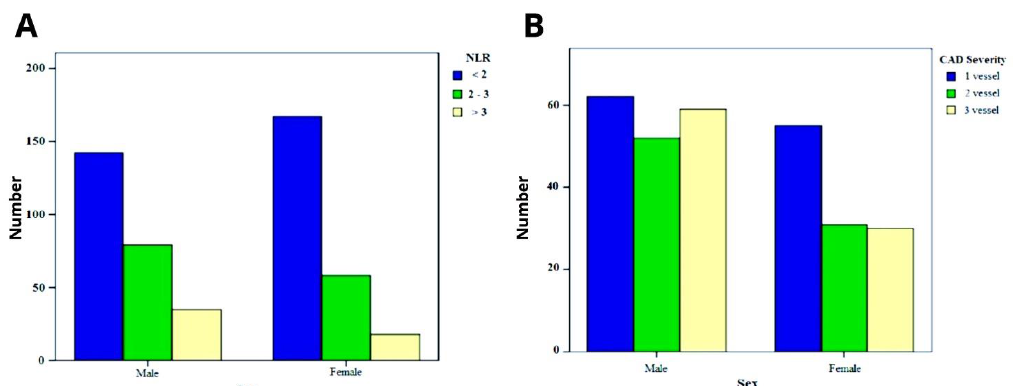
Figure 2. Association between gender and NLR and CAD severity; A. Male patients had significant higher NLR. B. Male patients had significant more severe CAD The patients with one-vessel CAD had the least